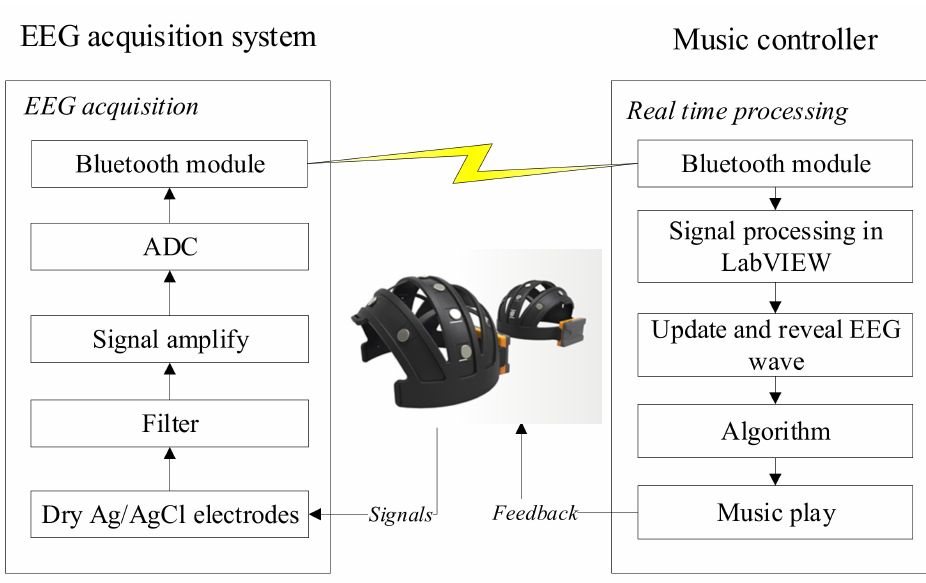
Figure 1. The overall framework of the proposed brain–computer interface (BCI) music